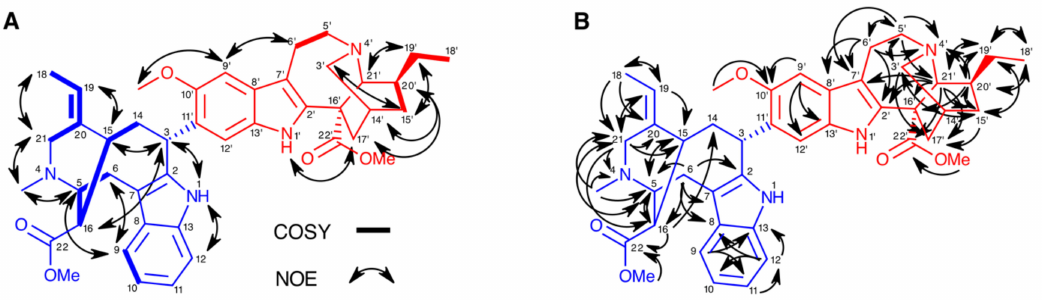
Figure 2. Key NOE ( A ) and HMBC ( B ) correlations in compound 1 . The vobasinyl and iboga subunits are highlighted in blue and red,